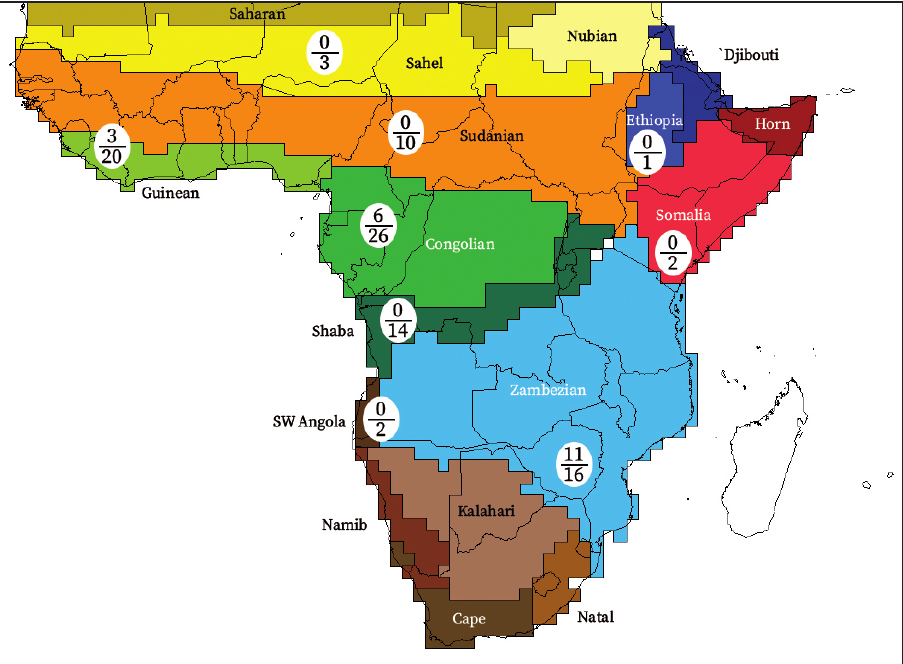
Figure 6. Xylopia species endemism by biogeographic region and subregion. For each region or subregion in which Xylopia species are present, the number above the line represents the number of endemic species and the number below the line the total number of species. Adapted from Figure 2 of Linder et al. (2012); figure used with the permission of the authors and of John Wiley & Sons,